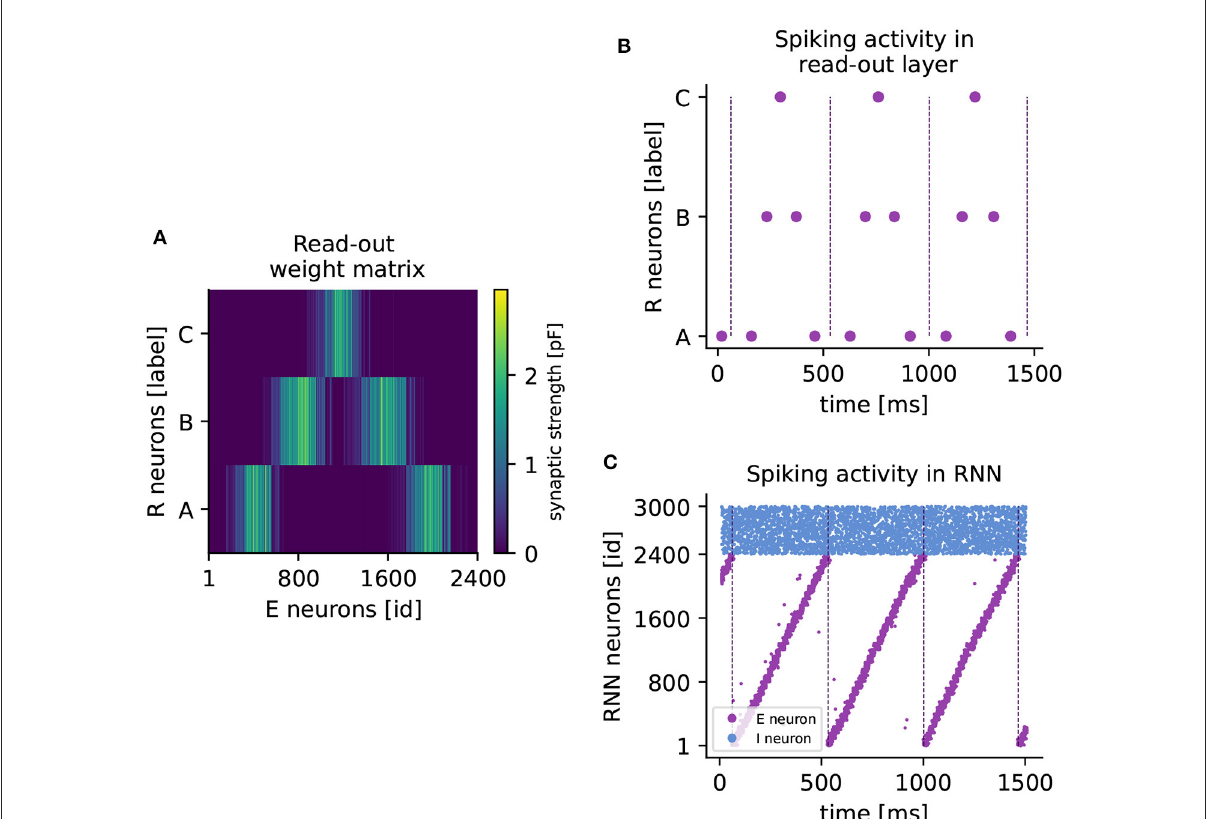
FIGURE4 Learning a higher-order sequence. (A) Weight matrix of connections from excitatory to read-out neurons (RE) after sequence ABCBA has been learned. Each read-out neuron is represented by its associated element ( A,B,C ). The colorbar indicates the synaptic weight. (B) Spiking activity of read-out neurons after learning the sequence ABCBA . Read-out neurons receive only input from the clock network. Dashed vertical lines mark the end (or the beginning) of a period of the clock. (C) Spiking activity of neurons in the RNN under spontaneous external input after training. Purple (blue) dots represent spikes of excitatory (inhibitory) neurons. Dashed vertical lines mark the end of each clock